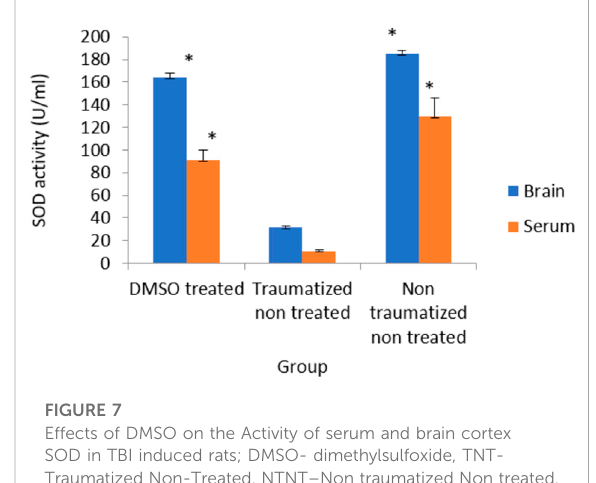
FIGURE 7 Effects of DMSO on the Activity of serum and brain cortex SOD in TBI induced rats; DMSO- dimethylsulfoxide, TNT- Traumatized Non-Treated, NTNT – Non traumatized Non treated.